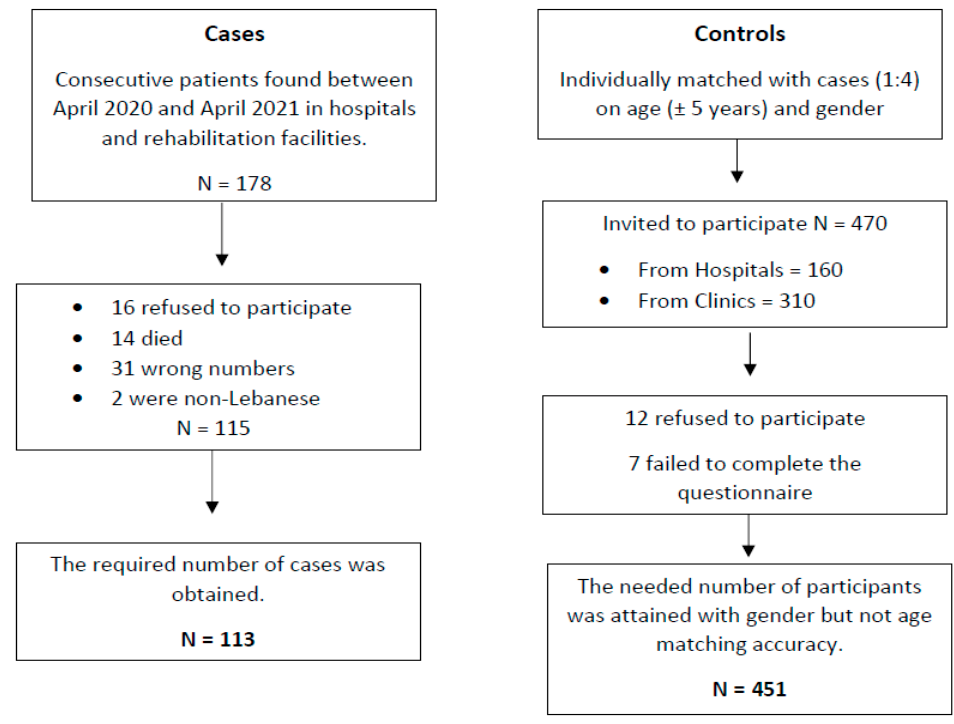
Figure 1. Participants’